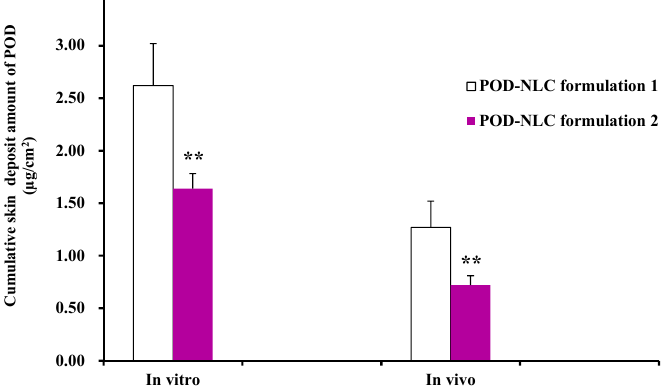
Figure 4. In vitro and in vivo rat skin deposit amounts of POD at 8 h after the topical treatment of POD ‐ NLC formulation 1 or POD ‐ NLC formulation 2 . Note: “**” represents p ˂ 0.01 compared with POD ‐ NLC formulation 1 .